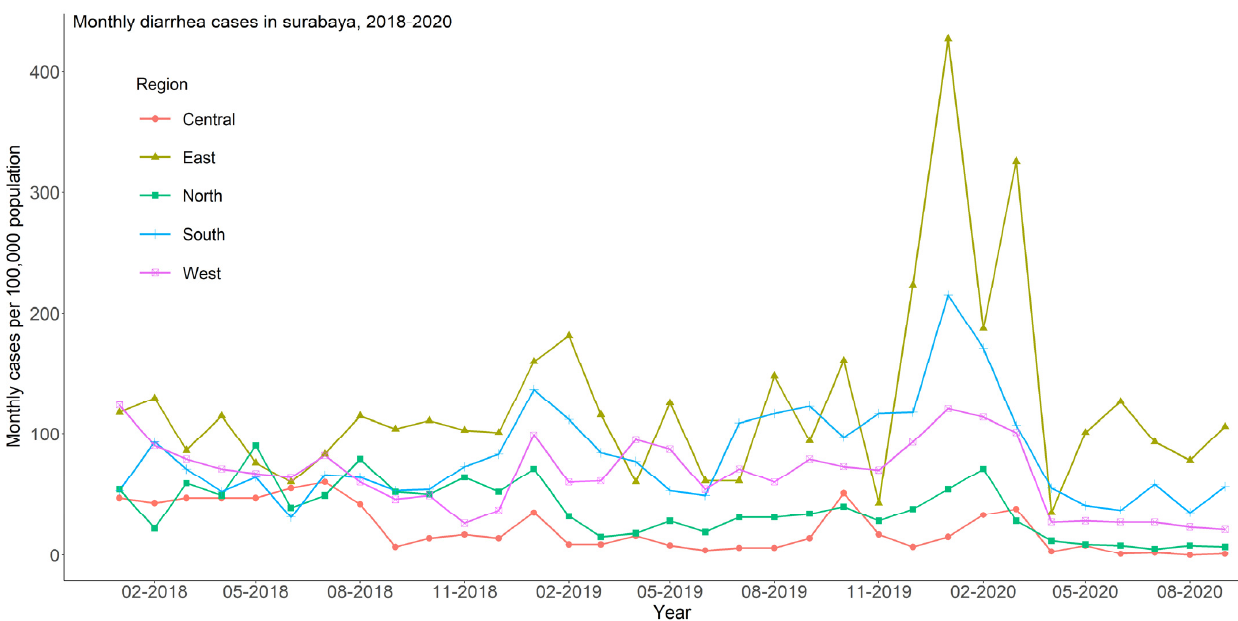
Figure 2. Monthly diarrhea cases in Surabaya from January 2018 to September 2020.